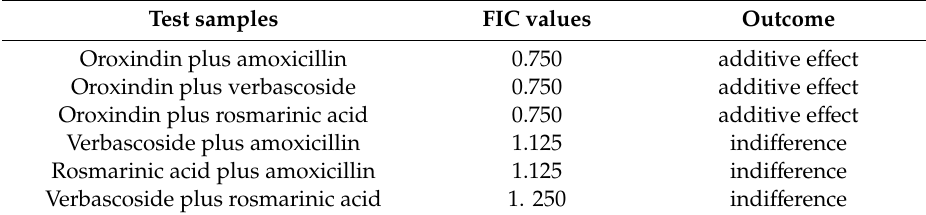
Table 3. Fractional inhibitory concentration (FIC) values of test samples for ATCC-43504. Test